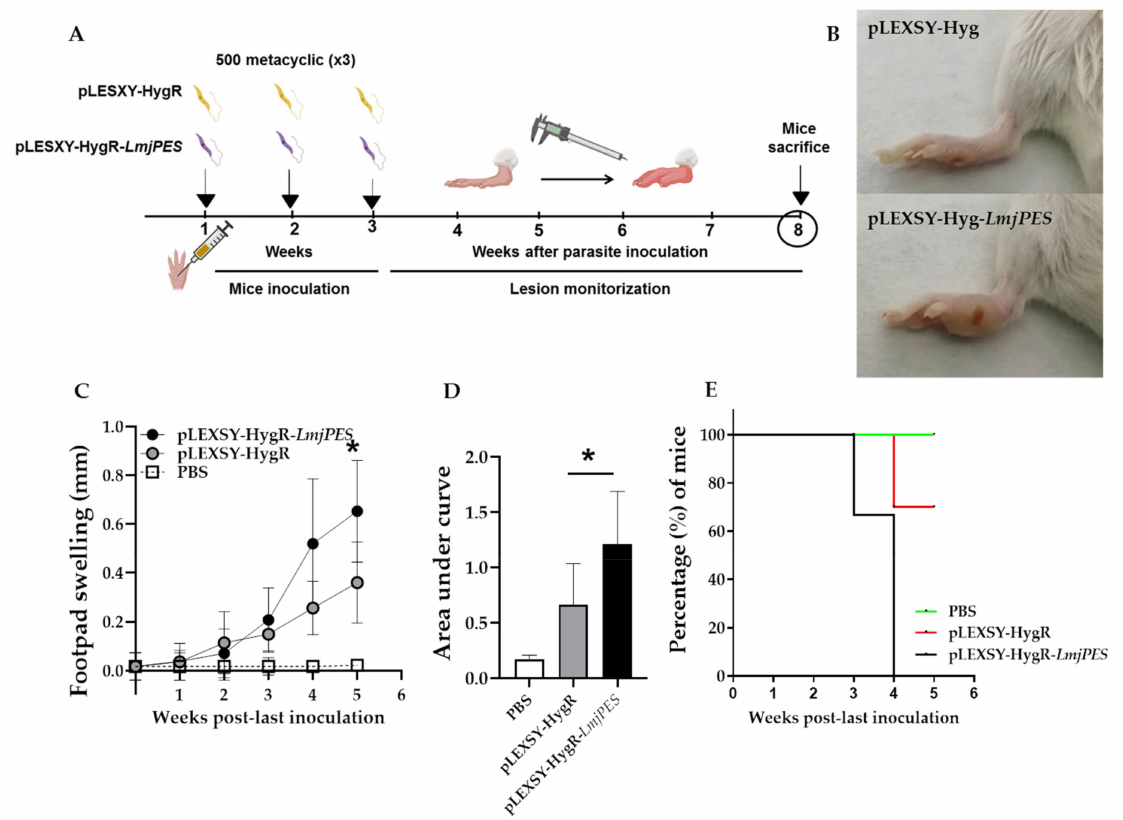
Figure 7. LmjPES overexpressing parasites exhibited higher and faster footpad inflammation in BALB/c mice than non- overexpressing parasites. ( A ) Schematic representation of the experimental setting. During the inoculation period, animals were subcutaneously infected in the right footpad with 500 metacyclic parasites, overexpressing (pLEXSY-HygR- LmjPES ) or non-overexpressing control (pLEXSY-HygR) LmjPES . Three cycles of inoculation were carried out once a week. After the last inoculation, the swelling was measured weekly until the end of the experiment (lesion monitorization). ( B ) Representative images of inoculated footpads of mice infected with parasites overexpressing (pLEXSY-HygR- LmjPES ) or control (pLEXSY- HygR) LmjPES . ( C ) Footpad swelling measured weekly until five weeks after the last parasite inoculation with both pLEXSY-HygR and pLEXSY-HygR- LmjPES strains. ( D ) Area under the curve for footpad swelling from uninfected (PBS) mice and inoculated with pLEXSY-HygR and pLEXSY-HygR- LmjPES parasites. ( E ) Percentage of mice with no significant lesion development after being infected by LmjPES overexpressing (pLEXSY-HygR- LmjPES ) and non-overexpressing parasites (pLEXSY-HygR). Significant lesion was defined as a swelling >0.6 mm. Survival curves were calculated with PRISM version 5.0. The bars represented the means ( ± SD) (* p <